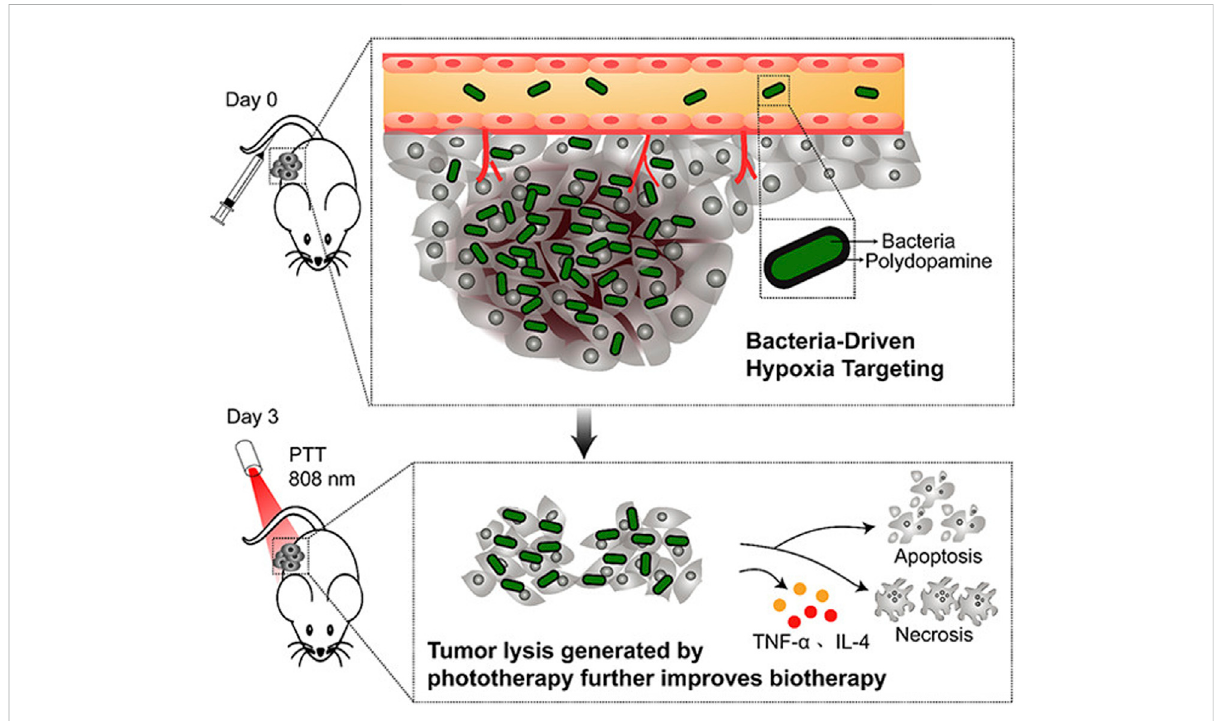
FIGURE 7 Bacteria combined with polydopamine-mediated photothermal therapy on